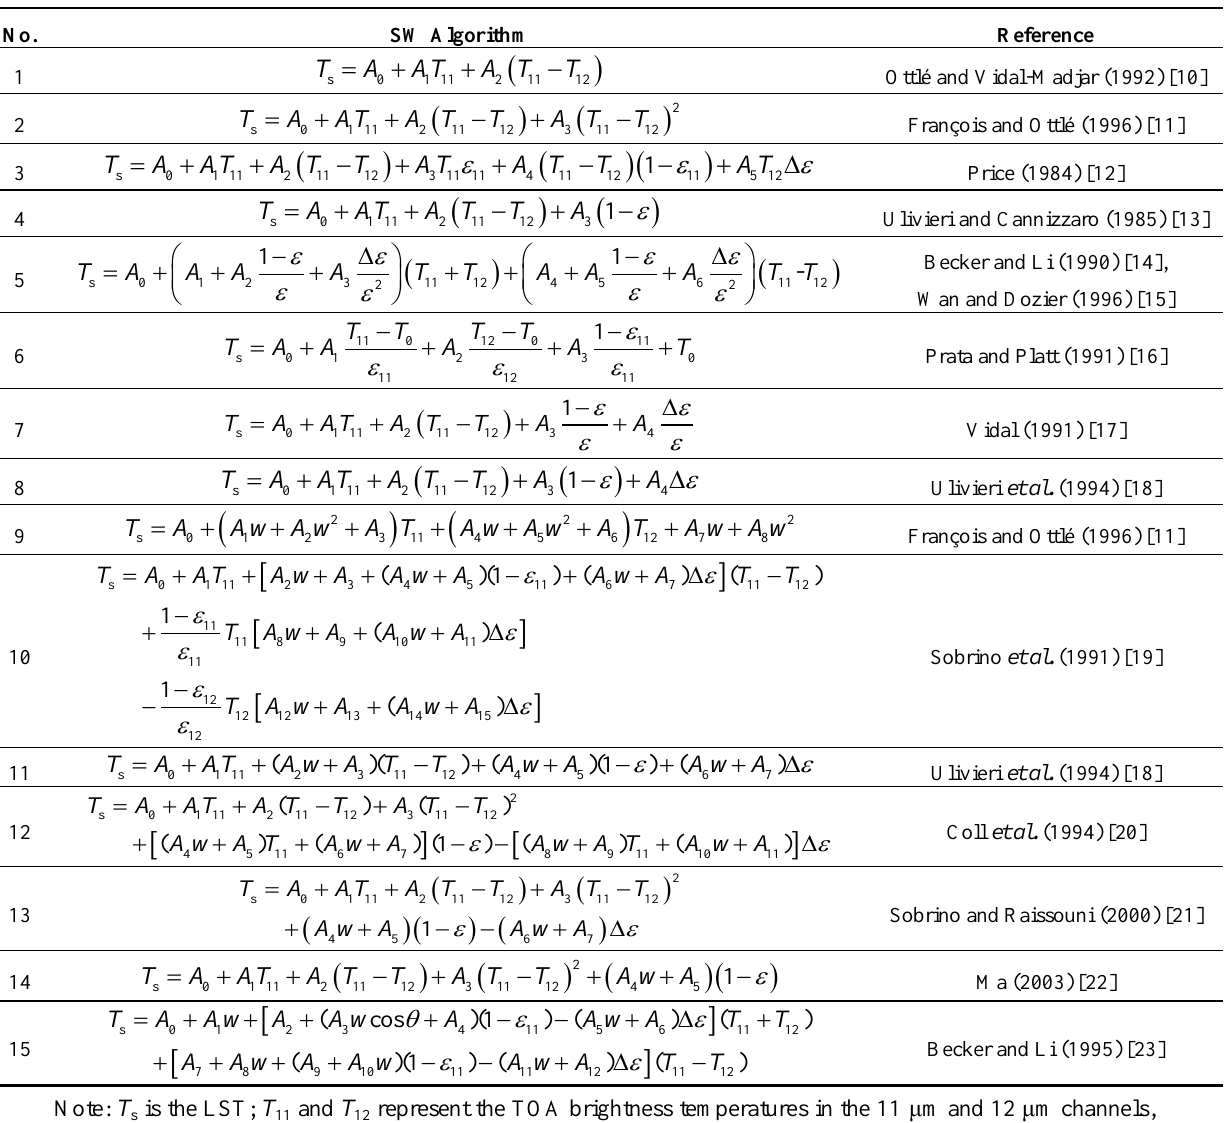
Table 1. Split-Window (SW) algorithms published by studies in recent